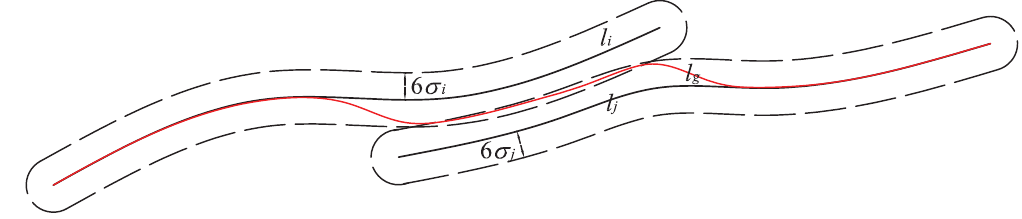
Figure 3. Illustration of point cluster grouping. Black solid lines are l i and l j that are generated from point clusters c i and c j ; black dashed lines indicate the 6 σ buffer regions; and red solid line l g is generated by c g , which is produced by grouping c i and c j